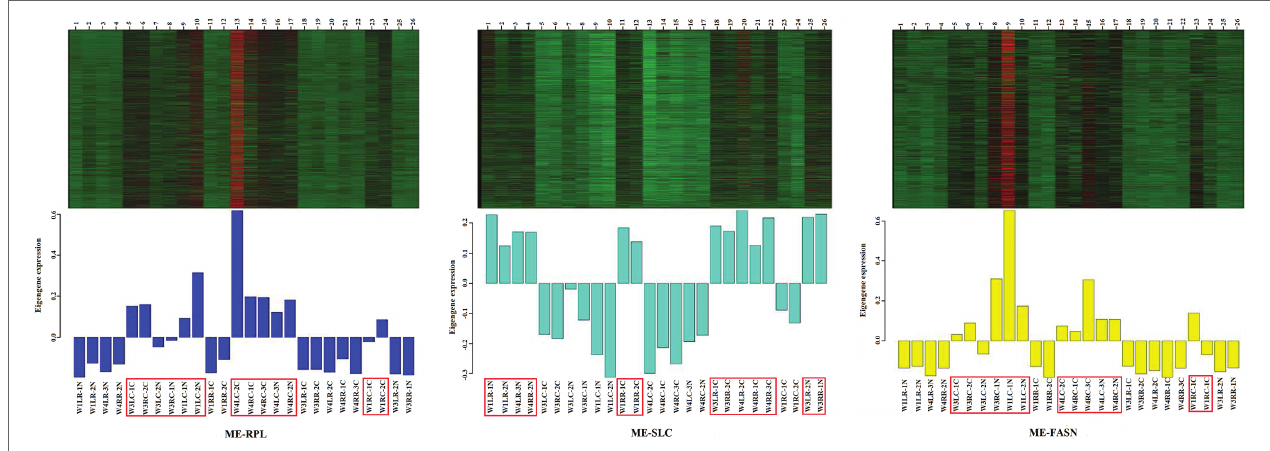
FIGURE 8 | Heatmap visualization of eigenvalues of “ME-RPL,” “ME-SLC,” and “ME-FASN” modules. Upper portion of the figure shows the gene expression heatmaps. Red indicates upregulated; green indicates downregulated. Lower portion of the figure shows the module eigenvalues in different samples, the displayed gene is upregulated/downregulated in the respective module.